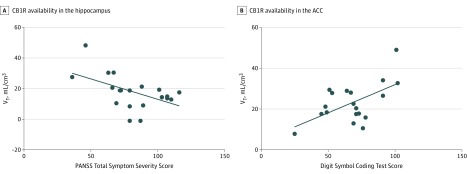
Association Between Cannabinoid 1 Receptor (CB1R) Availability and Symptom Severity and Cognitive FunctioningCannabinoid 1 receptor availability in the hippocampus and anterior cingulate cortex (ACC) was indexed using the distribution volume (VT) of carbon 11–labeled MePPEP. A, The distribution volume in the hippocampus was inversely associated with Positive and Negative Syndrome Scale total symptom severity scores (R = −0.50; P = .02). Scores ranged from 36 to 116, where higher scores indicated greater symptom severity. B, Distribution volume in the ACC was positively associated with cognitive functioning, as determined by the Digit Symbol Coding Test (R = 0.60; P = .01). Scores range from 25 to 102, where lower scores indicate greater cognitive impairment. Diagonal lines index the strength of a linear relationship between 2 variables, where a Pearson correlation coefficient of 1 indicates a positive association and −1 indicates a negative association.